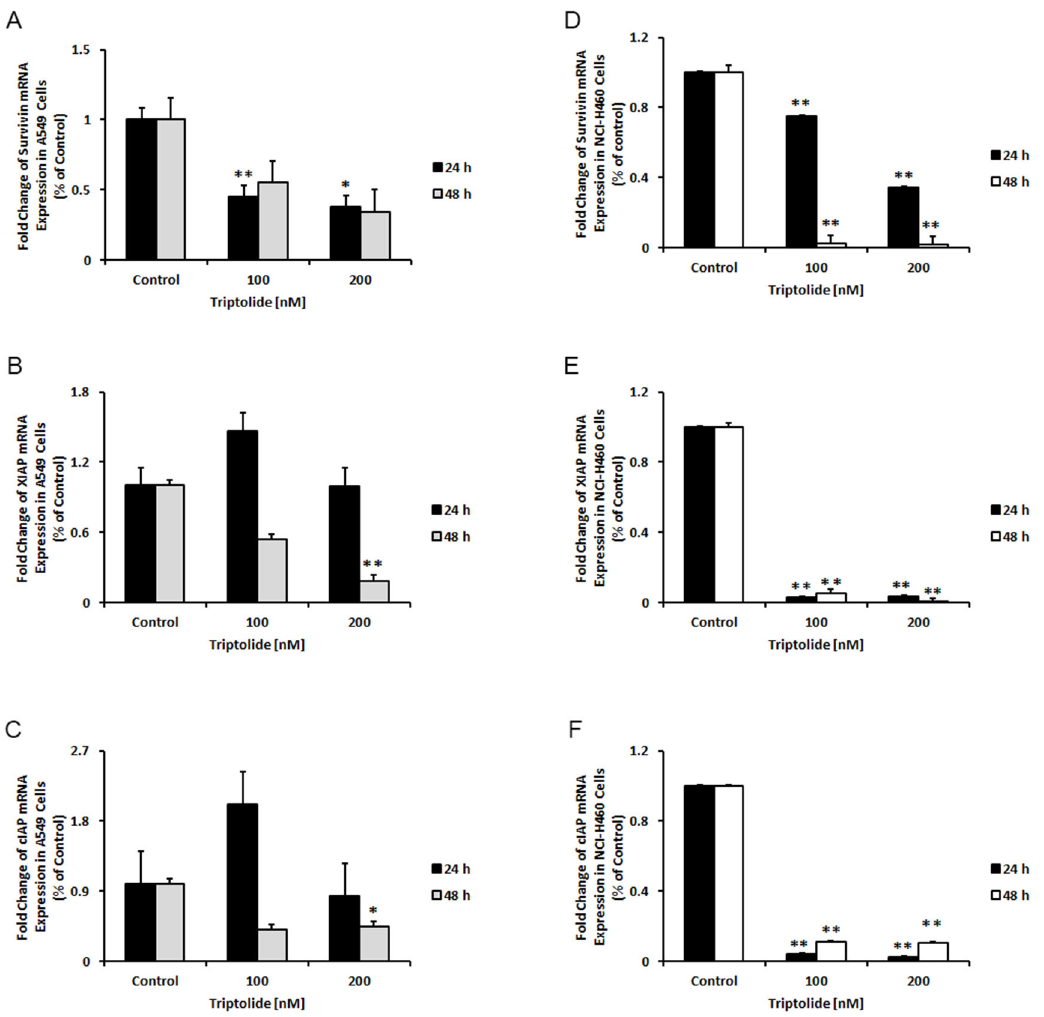
Figure 5. Triptolide down-regulates anti-apoptotic IAP genes in A549 and NCI-H460 cells. Triptolide significantly reduces the expression of IAP genes, (A and D) survivin, (B and E) XIAP and (C and F) c-IAP1. Columns , mean, bars , SE. Statistical significance of results was calculated with the Student`s t test (N=3) * P = 0.05; ** P =